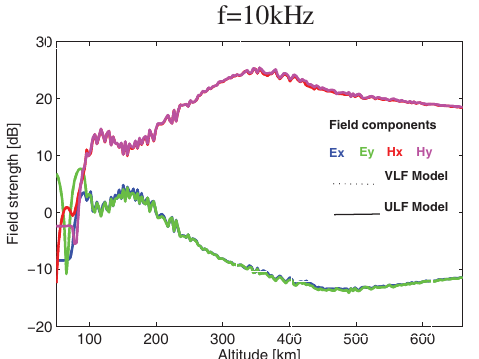
Figure 4. Intensity of four horizontal components of electric and magnetic field varying with altitude at 10kHz calculated with Nagano’s VLF model (dashed line) and our ULF model (solid line) (blue lines represent E x , green ones for E y , red being H x , and pur- ple for H y ).